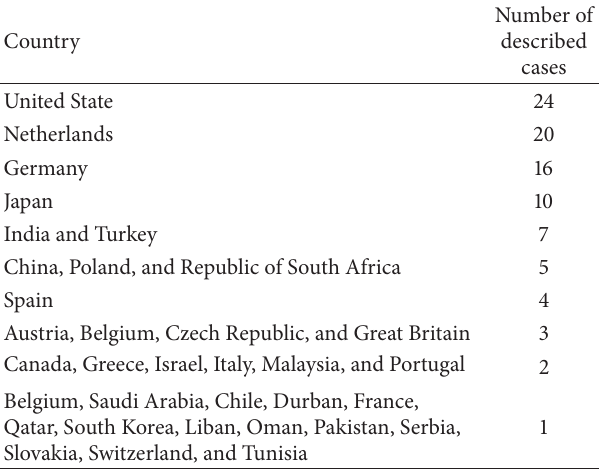
Table 1: Geographic distribution of arteria lusoria cases.